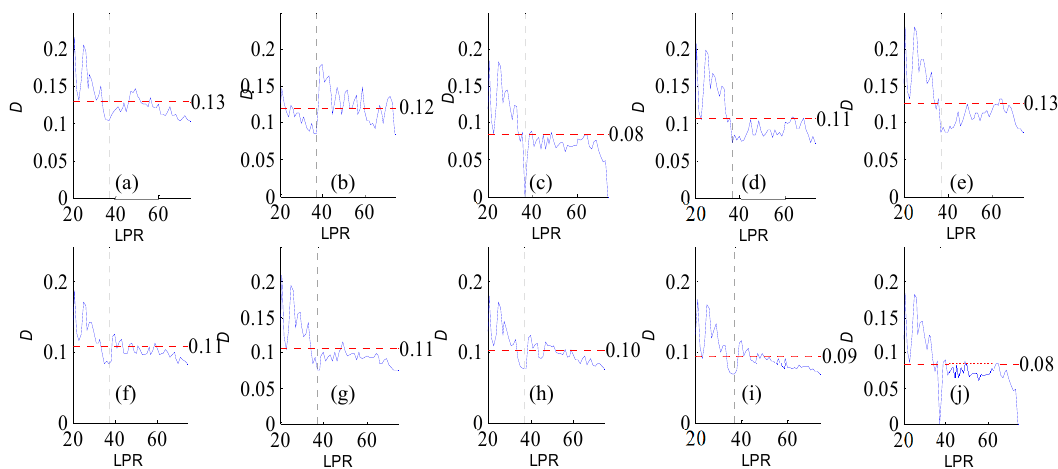
Figure A24. Variation of flow regime alteration degree (D) measured by the RVA with change in the length of post-impact flow time series (LPR) under a periodicity of 36 years. ( a ), ( b ), ( c ), ( d ), ( e ), ( f ), ( g ), ( h ), ( i ), and ( j ) correspond to pre-impact flow time series length = 26, 31, 36, 41, 46, 51, 57, 62, 67, and 72 years, respectively. The abscissa value for the vertical dotted line is 37. The ordinate value for the horizontal dotted line is the mean degree of flow regime alteration in each subfigure.